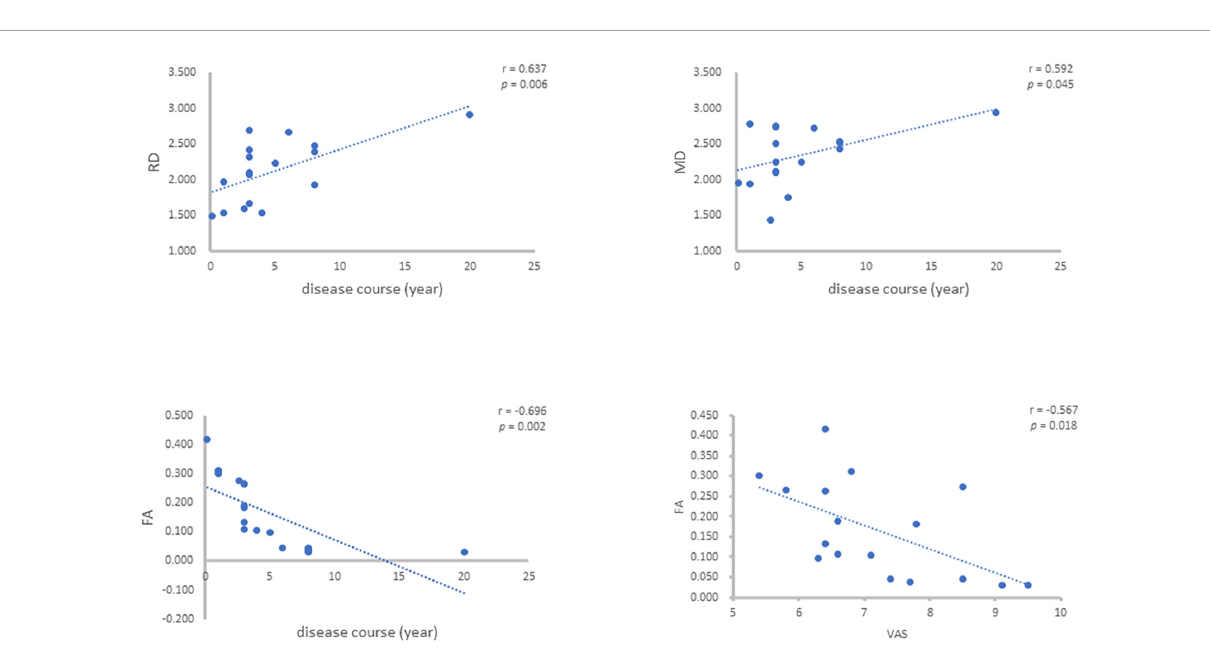
values of the four voxels in the REZ area before and after the operation of the 7 PTN patients were measured respectively in the affected side, and a total of 16 diffusion values (FA, MD,